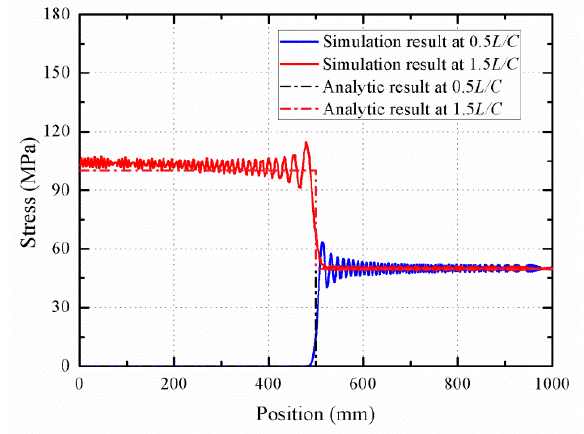
Figure 12. Stress profiles during the propagation and reflection of austenite elastic wave.